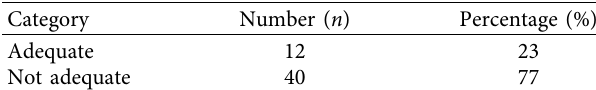
Table 4: The distribution of nutritional adequacy of female models in Malang